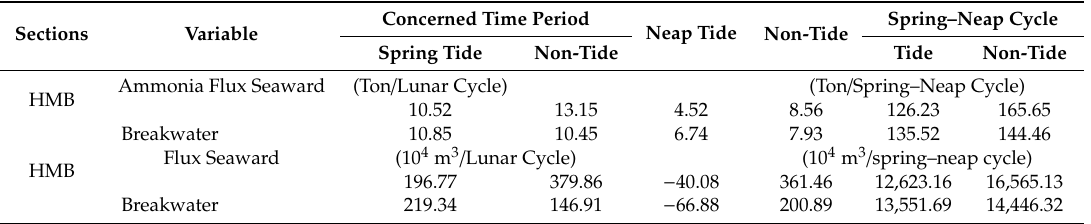
Table 2. Seaward flux of ammonia and water mass at the cross ‐ section of HMBand breakwater in both scenarios for a lunar cycle in the spring/neap phase and for a spring–neap cycle.